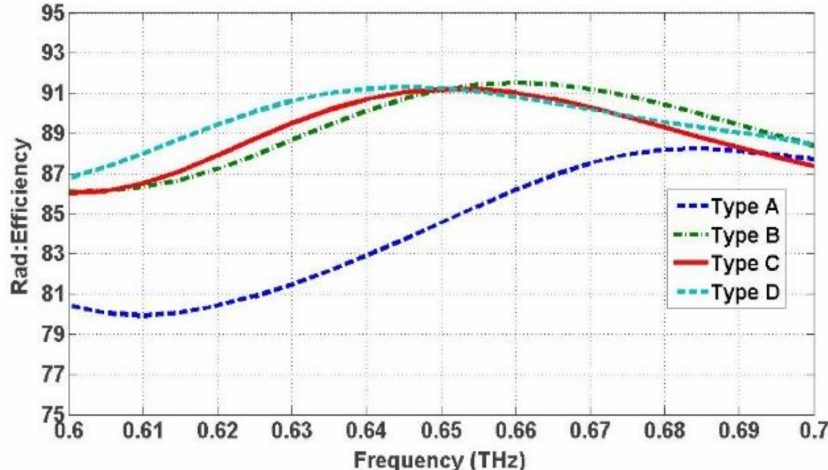
Figure 7. Comparison of radiation